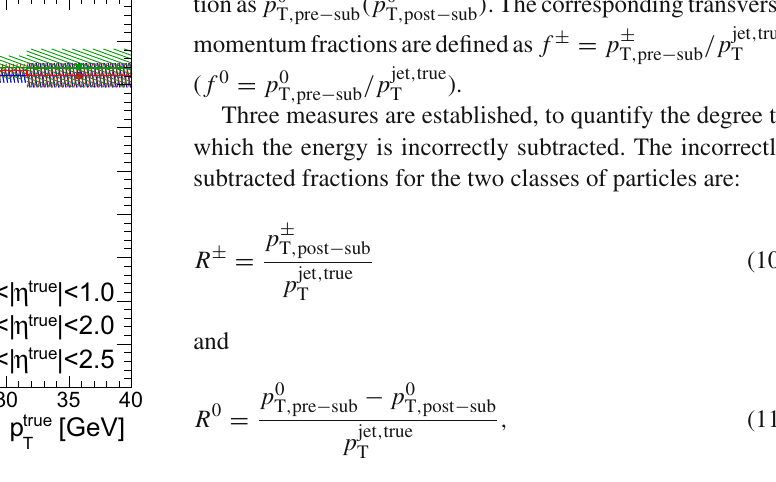
Fig. 19 The fraction of the true energy of a given particle considered in the subtraction procedure f clus after the inclusion of the split shower sub recovery algorithm. The data are taken from a dijet sample without pile- up with 20 < p lead